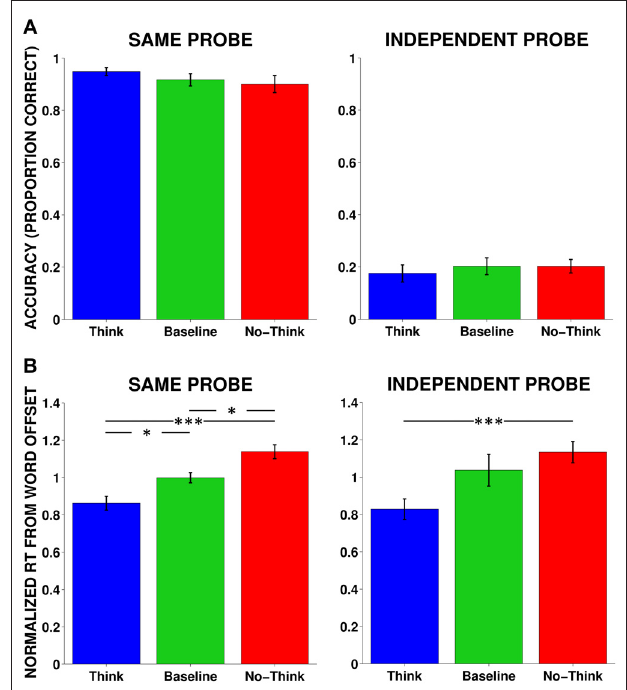
FIGURE 2 | Accuracy and response time (RTs) averaged across all subjects. (A) Behavioral accuracy (proportion correct) in the same and independent probe tests. No significant results were found. Same Probe: F ( 2,34 ) = 1.87, p = 0.17, η 2 = 0.14, Independent Probe: F ( 2,34 ) = 0.39, p = 0.68, η 2 = 0.02. (B) RT for normalized mean responses from word offset to the onset of the correct response for same probe and independent probe tests. Same Probe: F ( 2,34 ) = 10.92, p < 0.001, η 2 = 0.46, Independent Probe: F ( 2,34 ) = 3.78, p < 0.05, η 2 = 0.24. ∗ p < 0.05, ∗∗ p < 0.01, ∗∗∗ p <